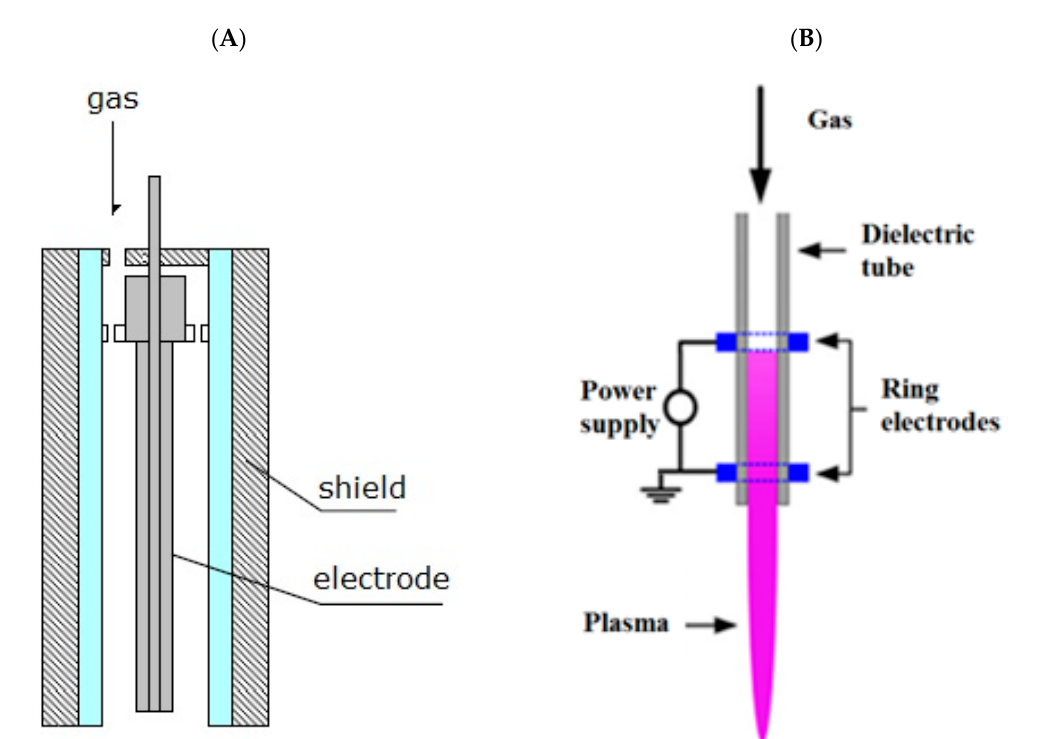
Figure 1. Schema of atmospheric pressure plasma jets: RF-type ( A ), DBD-type ( B ) [104,118].